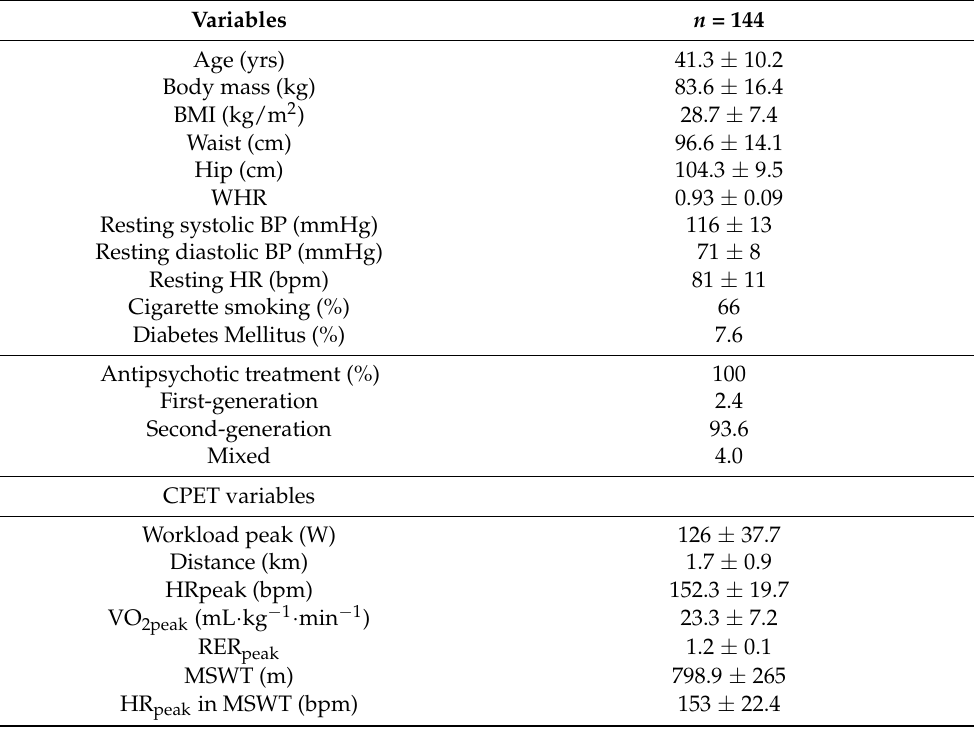
Table 1. Characteristics of the studied population. Values are means ± standard deviation or percentage